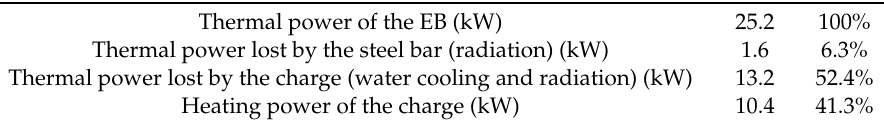
Table 9. Heat thermal balance at t = 40 min (power+ case).